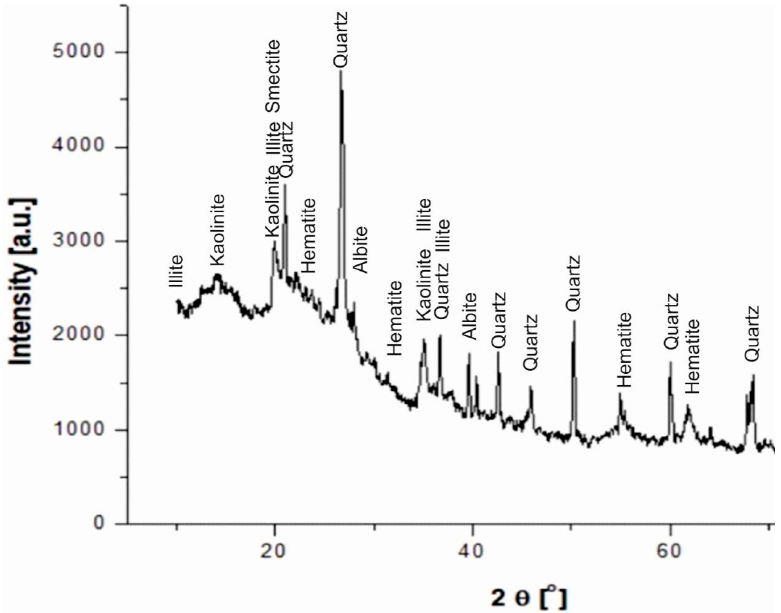
Figure 13. X-ray diffraction patterns of a raw diatomite sample from the Jawornik deposit. Figure 13. X-ray di ff raction patterns of a raw diatomite sample from the Jawornik